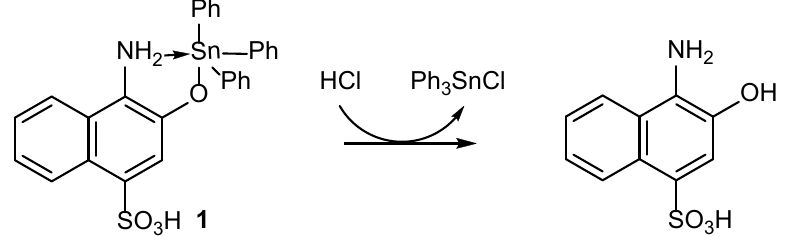
Figure 12. Complex 1 acts as a scavenger for HCl.